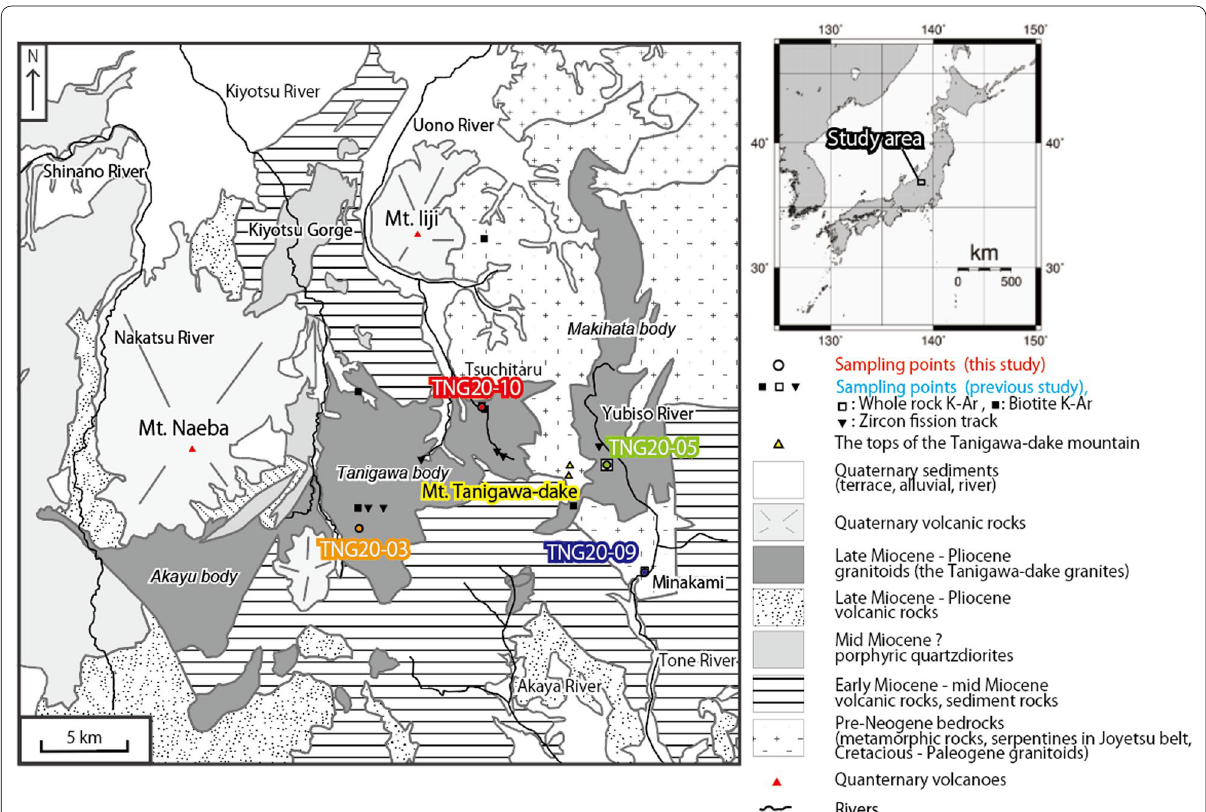
Fig. 1 Index map of the study area. The geologic map was modified from Sato (2016) and Geological Survey of Japan web page (https:// gbank. gsj. jp/ geona vi/ geona vi. php# 11,36. 83525 ,138. 87626). Circle points denote sampling localities. Colored circles denote sampling localities in this study. Sampling sites of the previous studies are shown by the following symbols. Filled square: K–Ar ages of biotite (Kawano et al. 1992; Sato 2016;